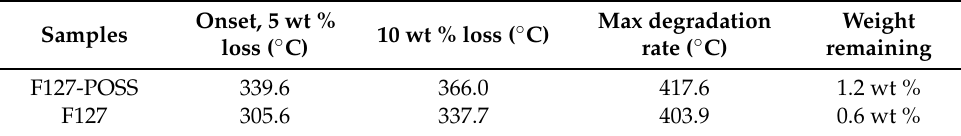
Table 2. Thermal degradation analysis of F127-POSS and F127.